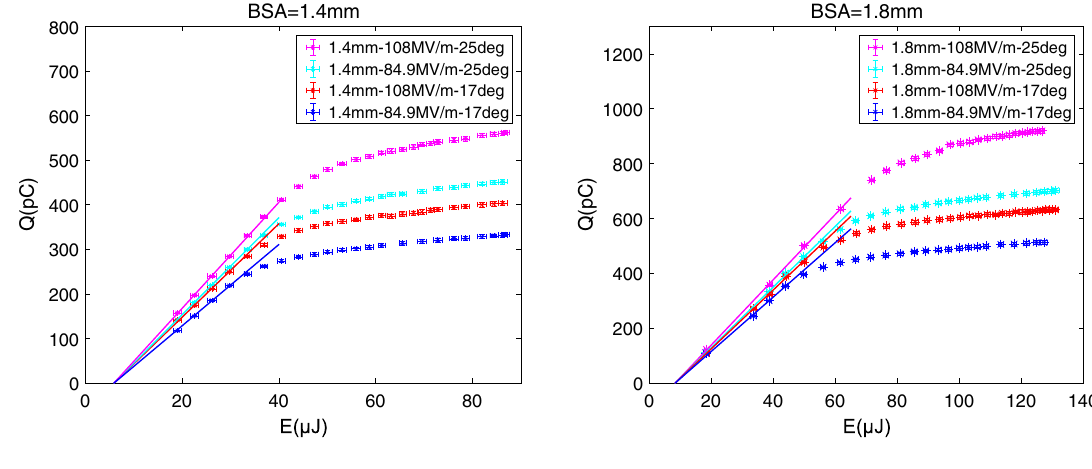
FIG. 7. Measured QE curves.